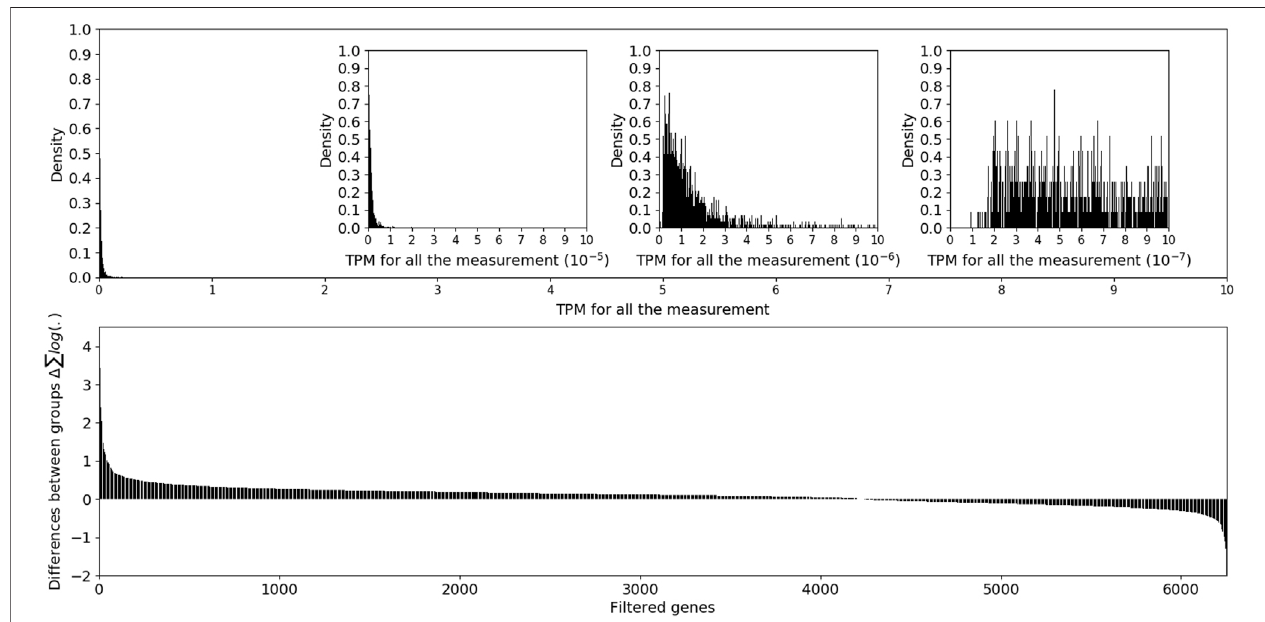
FIGURE1| TheupperpanelshowedtheoveralldistributionofmRNATPMvalues,andthelowerpanelshowedthelog2-transformedfold-changein fi lteredgenes.